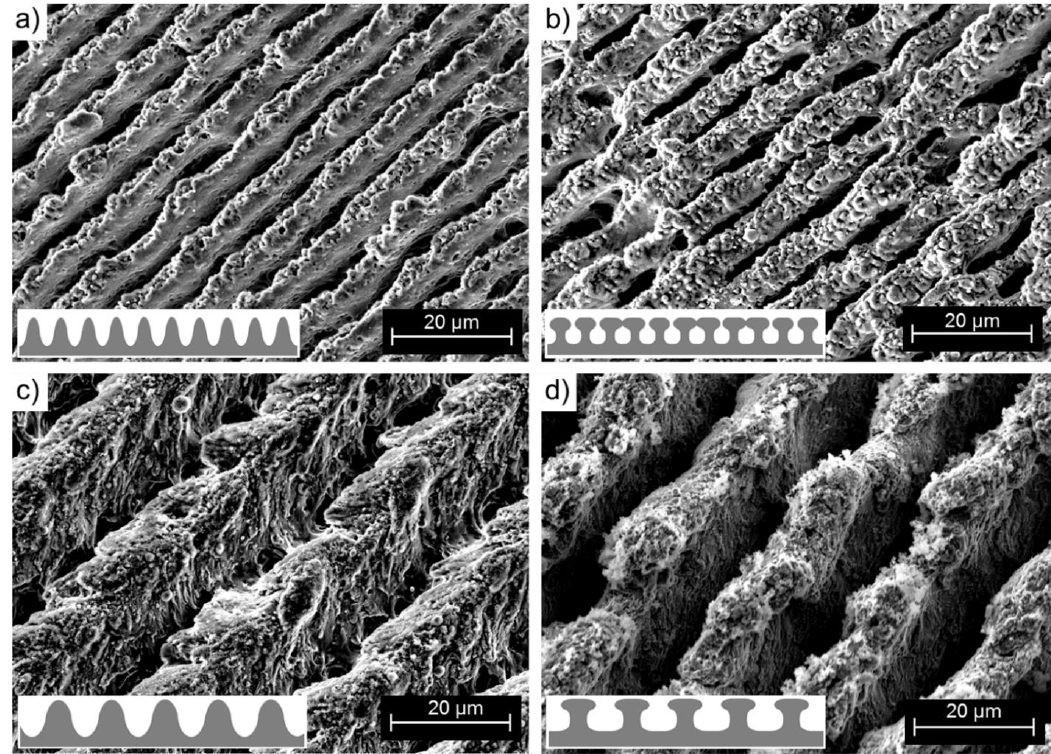
Figure 8. DLIP treated aluminum surfaces: ( a ) Λ = 8.0 µm, PO = 98%, repetition rate f rep = 0.1 kHz; ( b ) Λ = 8.0 µm, PO = 98%, repetition rate f rep = 5 kHz; ( c ) Λ = 19.0 µm, PO = 98%, repetition rate f rep = 0.1 kHz; and ( d ) period Λ = 19.0 µm, PO = 98%, repetition rate f rep = 0.1 kHz. Material: aluminum EN AW-5754 AlMg3 [43]. The used laser fluence per pulse was 3.2 J∙cm −2 .